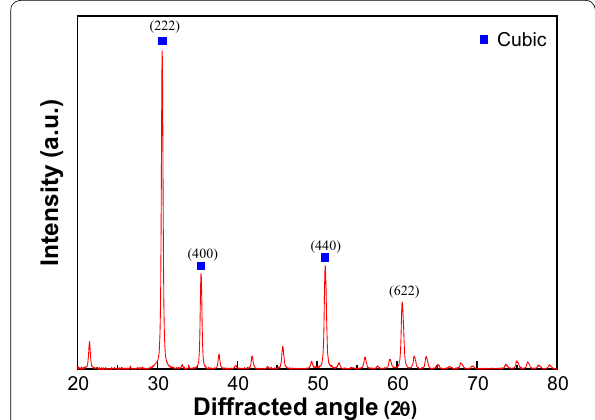
Fig. 3 X‑ray diffracted patterns of ITO‑NPs heat‑treated at 980